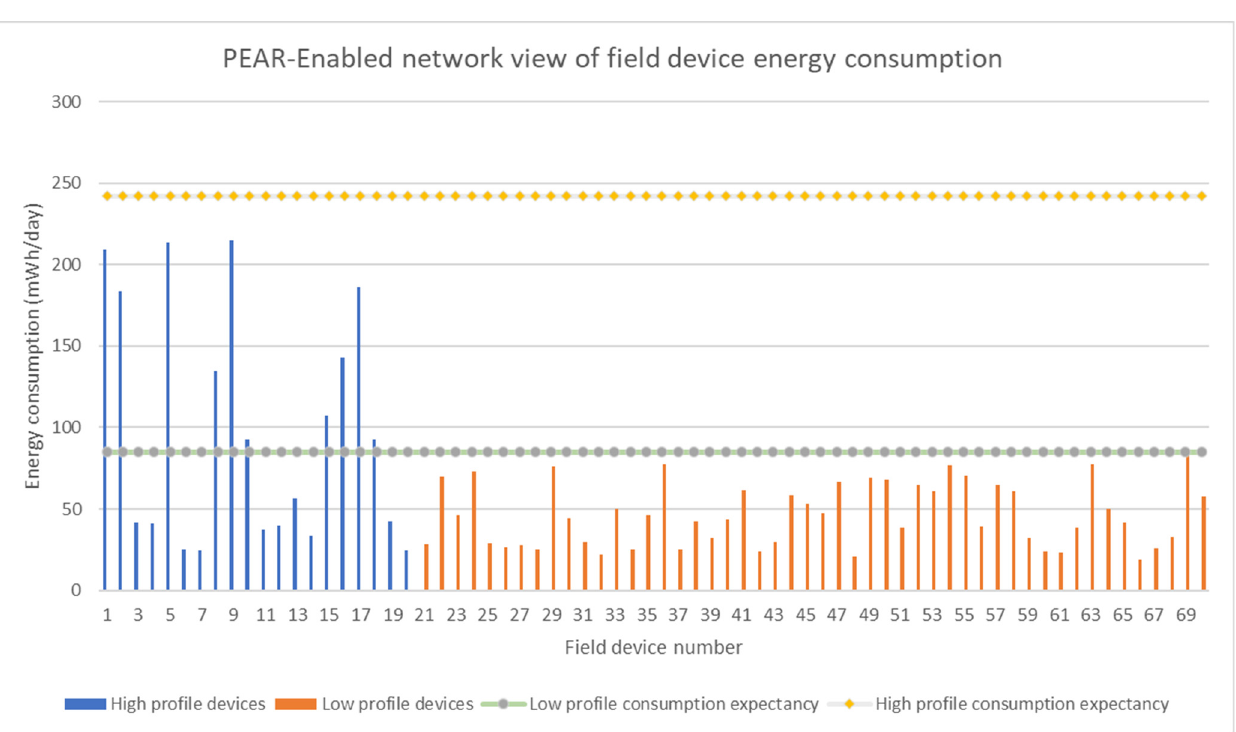
Figure 11. Average field device energy consumption for all devices in the network differentiated by the energy profile when PEAR is disabled.